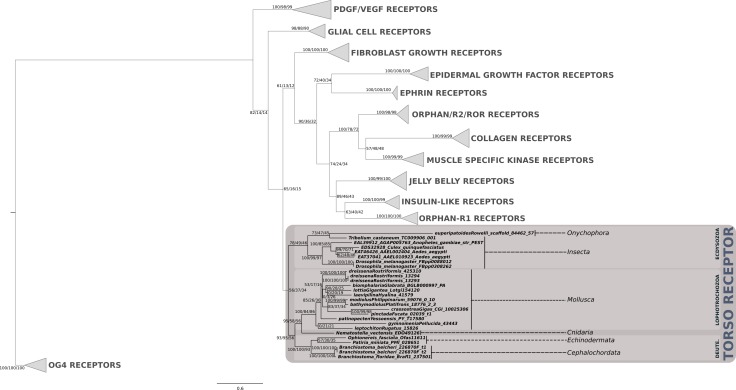
Phylogenetic analysis of the PTTH/trunk receptor tyrosine kinase torso showing the presence of torso receptor in cnidarians, lophotrochozoans, ecdysozoans and deuterostomes.Support values for the tree nodes obtained from mrbayes, RAxML and PhyML are shown as percentage. Tree topology obtained from RAxML was used as a backbone, and conflicting topology branches from mrbayes and PhyML inferred trees are marked by brackets ([]) around the support values.